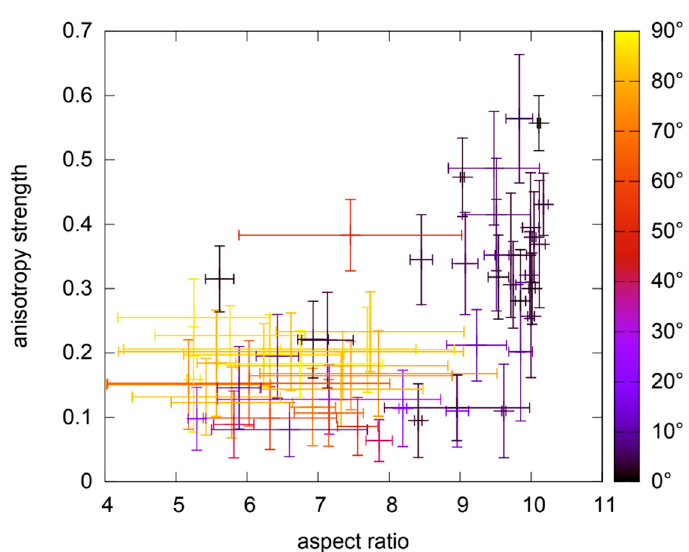
Figure 10. Correlation between velocity centroid anisotropy and column density autocorrelation structure. Each data point represents one snapshot from the gravitational stage of cloud simula- tions [38]. The horizontal axis shows the aspect ratio of the autocorrelation function from the top 10% contour of the column density. The vertical axis shows the degree of anisotropy (0–1) of the velocity centroid in the same region. The colour indicates the offset between the orientation of the column density autocorrelation and the orientation of the velocity centroid anisotropy (the orientation along which the centroid is most stable). Since the structure elongation is perpendicular to the B-field in the simulation, the velocity centroid anisotropy varies from being parallel to perpendicular with B-fields as density increases, while the dominant velocity changes from turbulence to contraction. This is consistent with the observation in Figure 11.